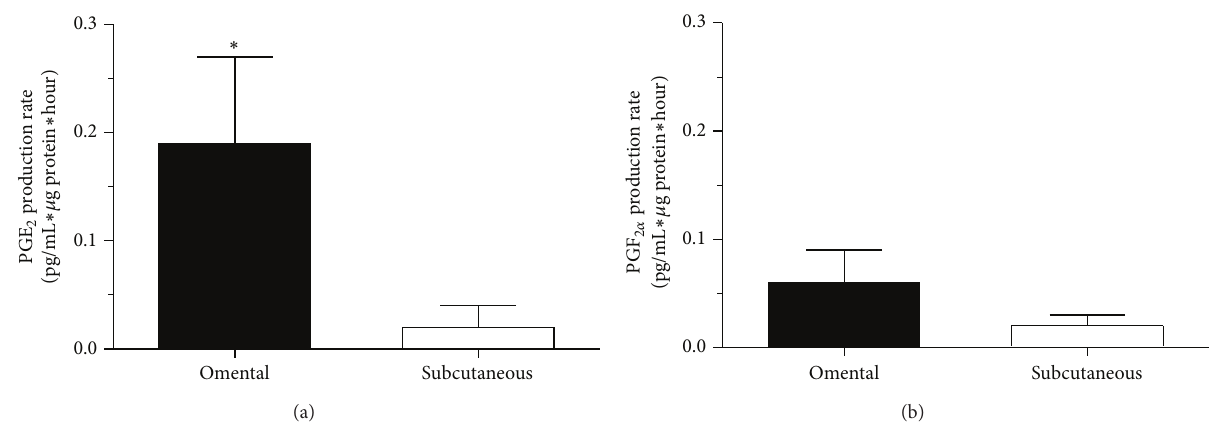
Figure 6: PGE 2 (a) and PGF 2𝛼 (b) production rate during omental ( 𝑛 = 4 ) or subcutaneous ( 𝑛 = 5 ) preadipocyte differentiation (0h to 8 days). PGs production rate was expressed as pg/mL ∗𝜇 g protein ∗ hour. Mean ± SEM are shown. ∗ 𝑃 ≤ 0.05